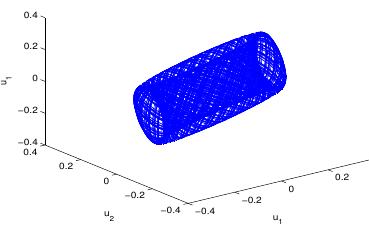
Figure 7. Simulation solution of (4.1) for ( α 1 ,α 2 ) = (0 . 001 . − 0 . 050): showing a torus in u 1 − u 2 − u (cid:48) 1